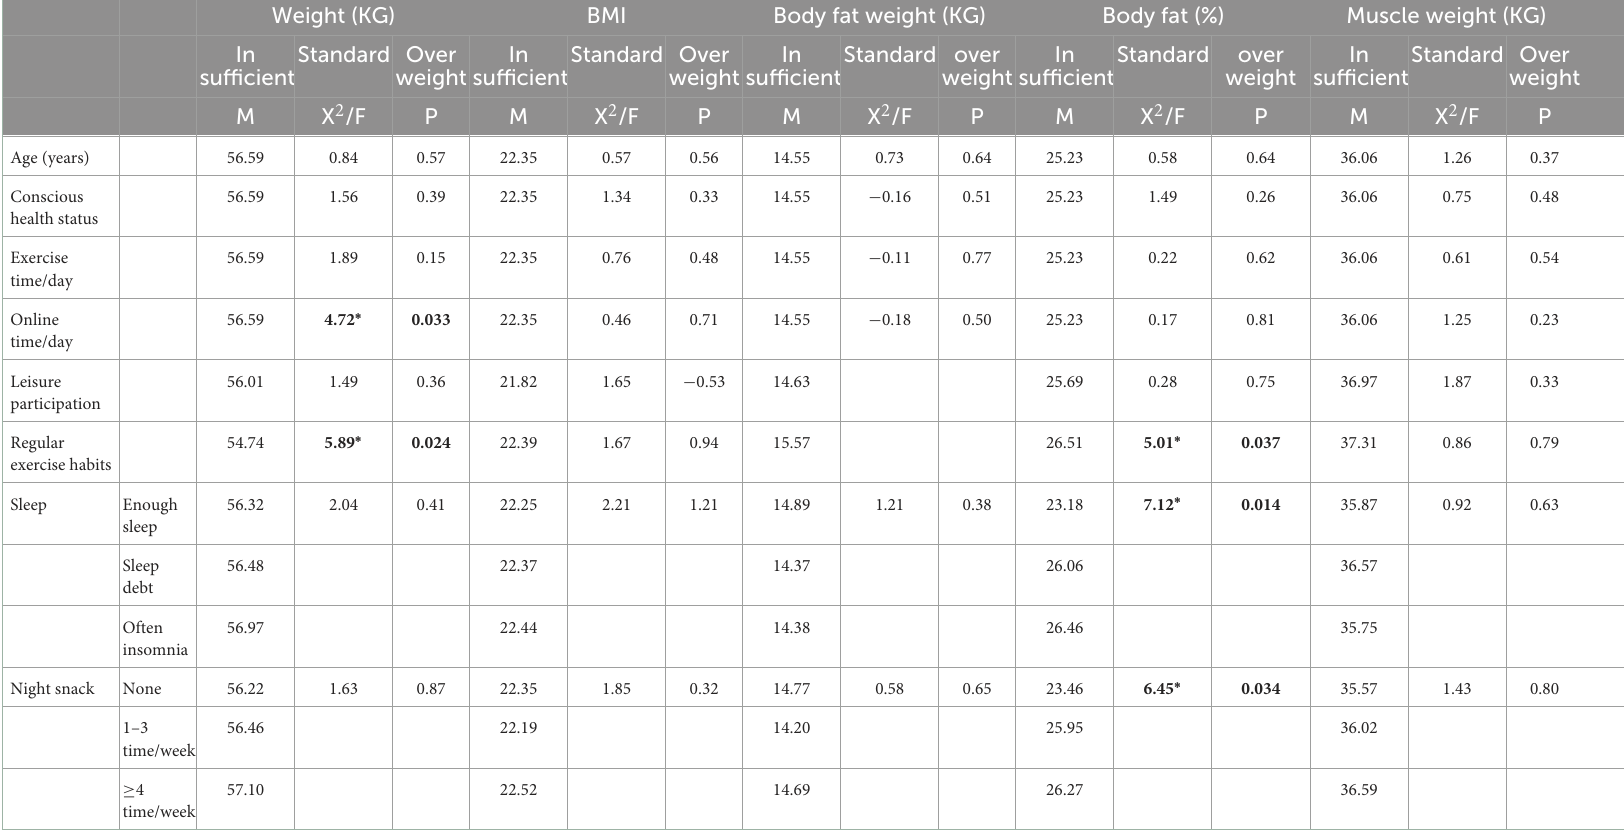
TABLE 4 Statistical table of the influence of College Students’ demographic variables on their body shape. BMI Body fat weight (KG) Body fat